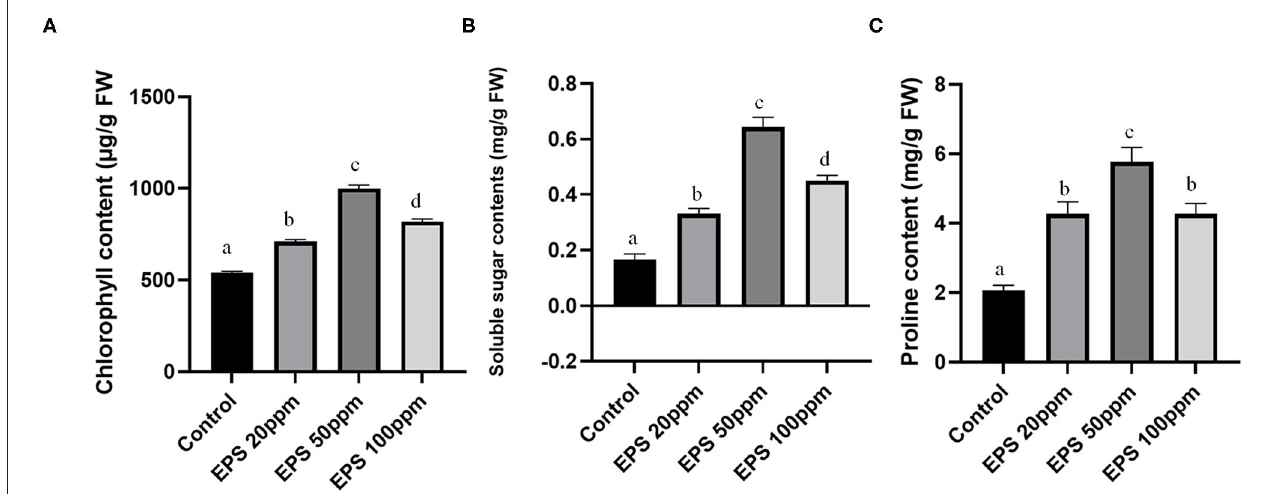
FIGURE 5 | The effect of EPS foliar spray (20, 50, and 100 ppm) on chlorophyll content (A) , soluble sugar content (B) , and proline content (C) on rice seedlings. Values on the graphs are the means ± standard error (SE) of three replicates. Tukey’s Multiple comparison test was performed. The different letter a, b, c, d indicates significance differences in comparison to the control plant (At, P <